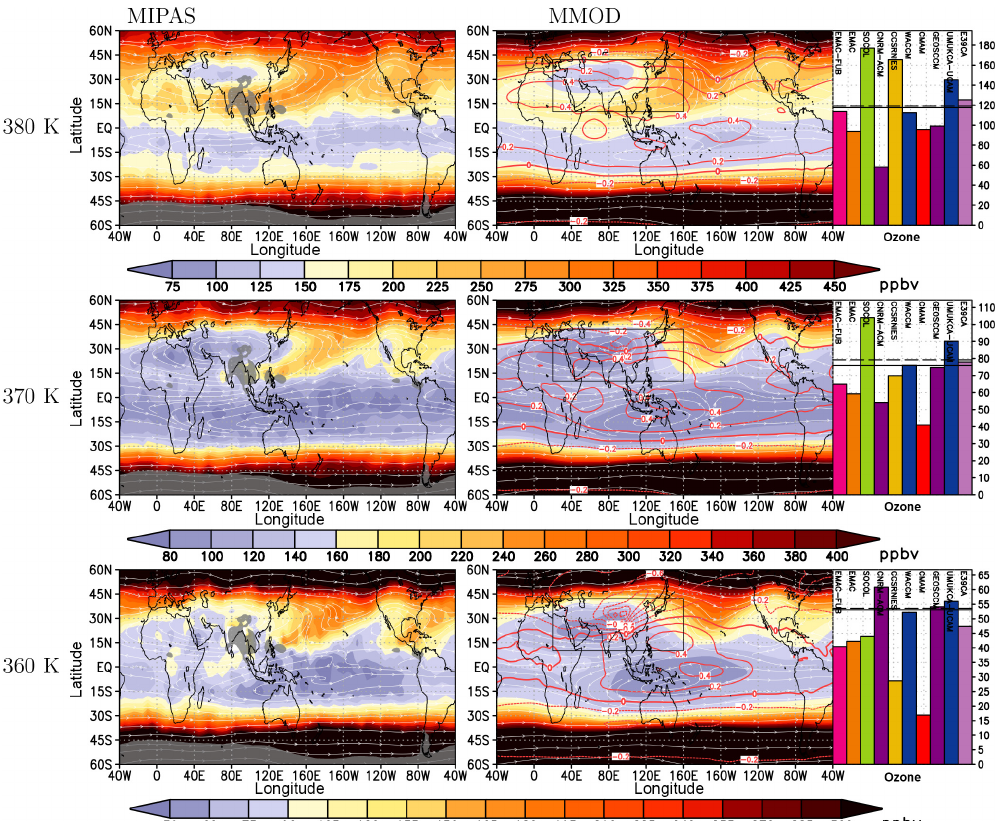
Figure 5. As Fig. 3 but for ozone in ppbv. The minimum of individual models within the area marked by the black rectangle is displayed as bar charts, where the solid horizontal line represents the MMOD and the dashed horizontal line represents the minimum of MIPAS.